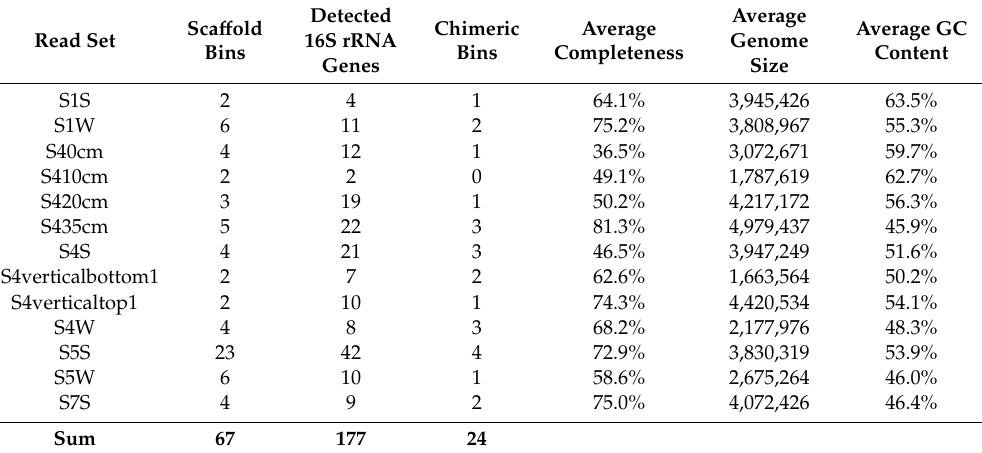
Table 2. Metagenomic binning statistics for Calumet read